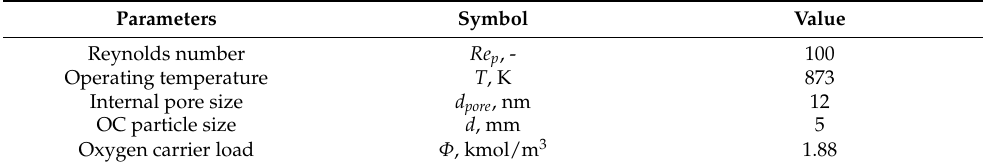
Table 2. The parameters of default operating condition with a single large oxygen carrier (OC) particle.